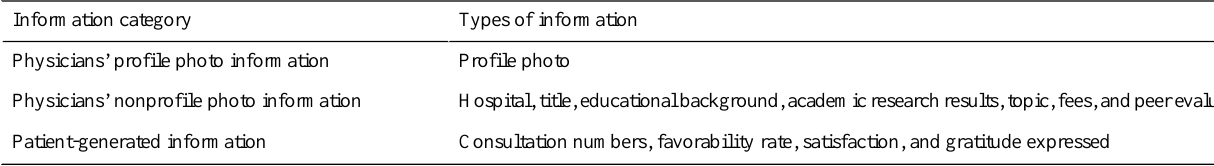
Table 1. Classification of physician